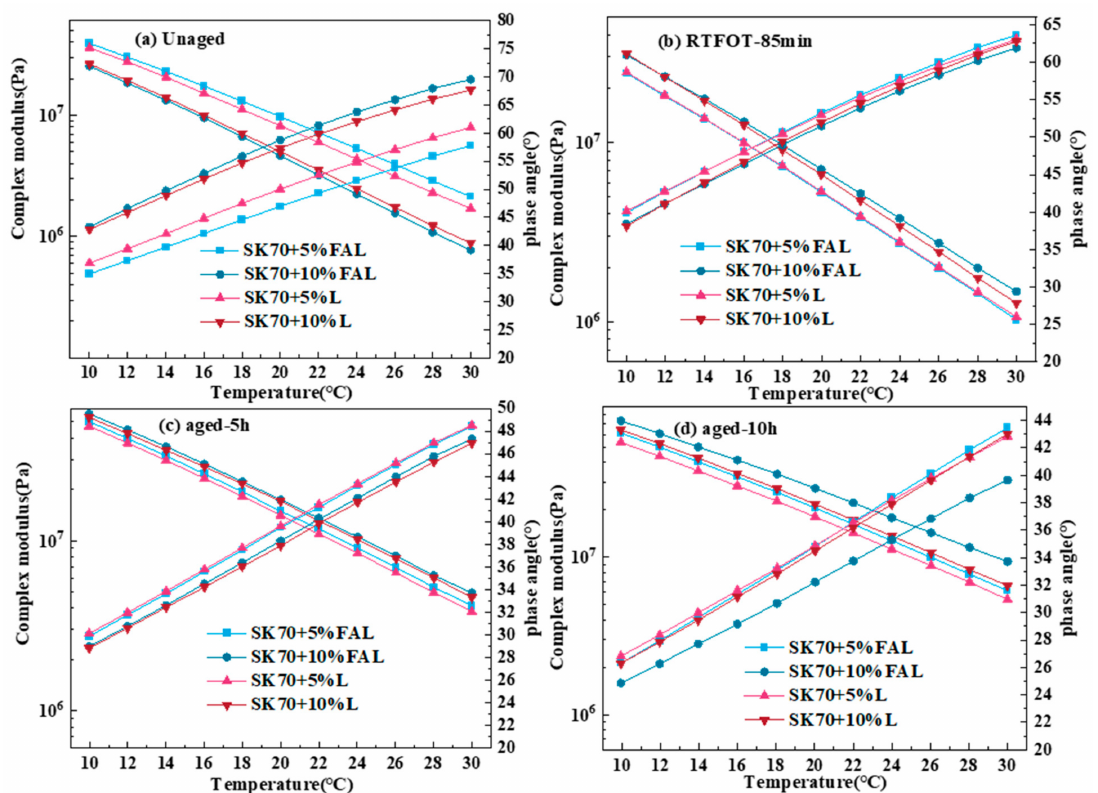
Figure 8. Variation curves of complex modulus and phase angle with temperatures for each asphalt specimen at different aging